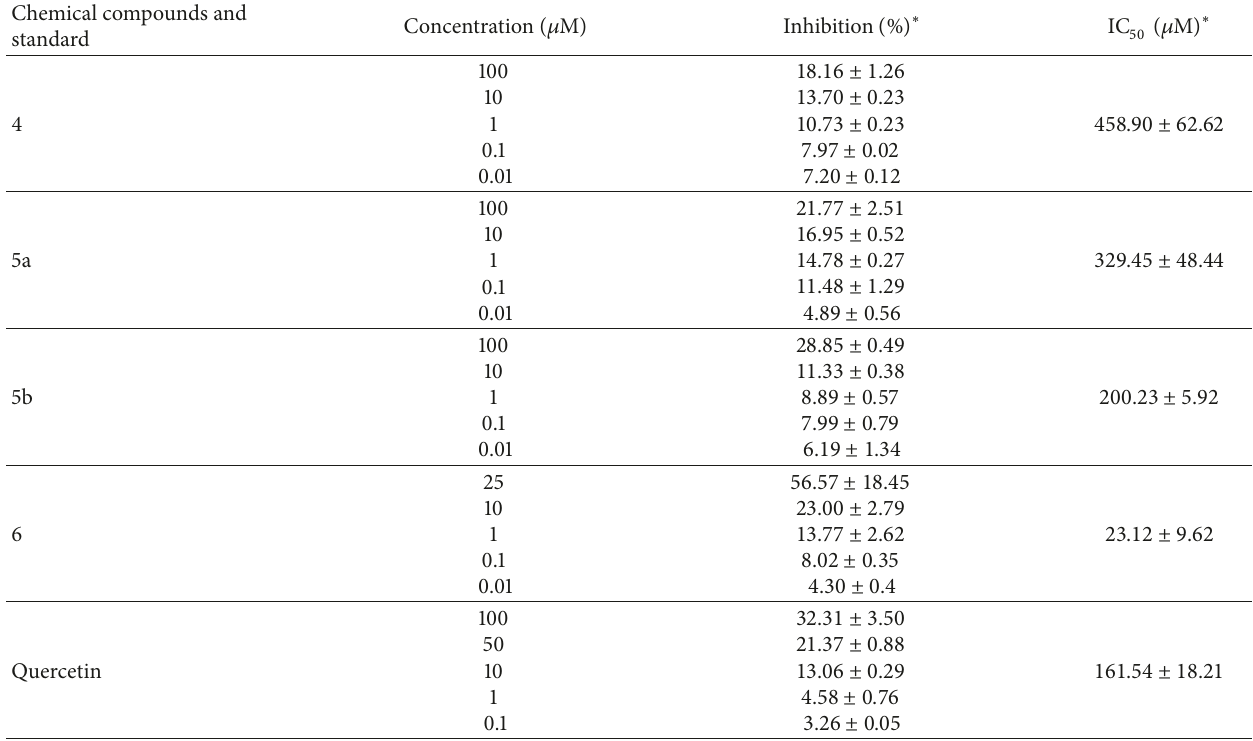
Table 4: The neuraminidase inhibitory activity of different concentrations of S-substituted perhalonitrobuta-1,3-diene compounds. Chemical compounds and